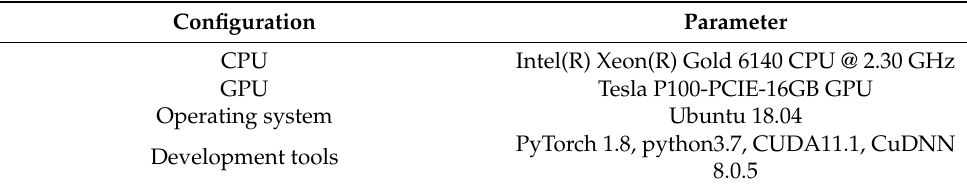
Table 1. Experimental environment.